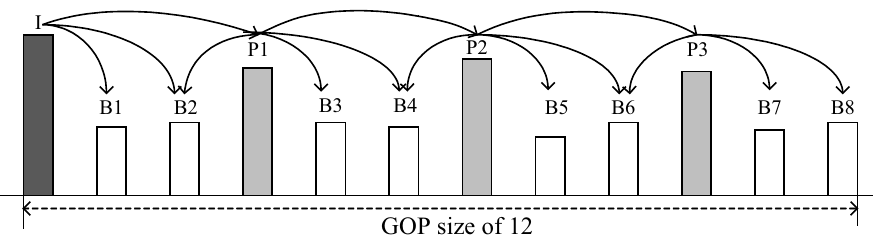
Figure 3. Hierarchical dependency among video